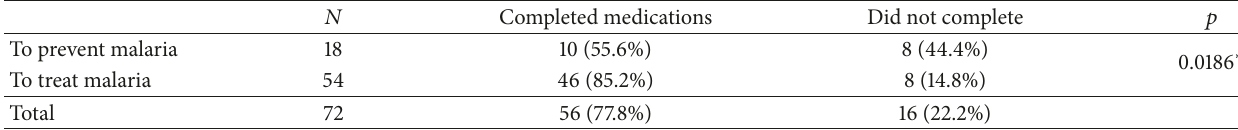
Table 5: Fisher’s exact test result of association between student’s health behaviour on use of prescribed medication and purpose of the medication